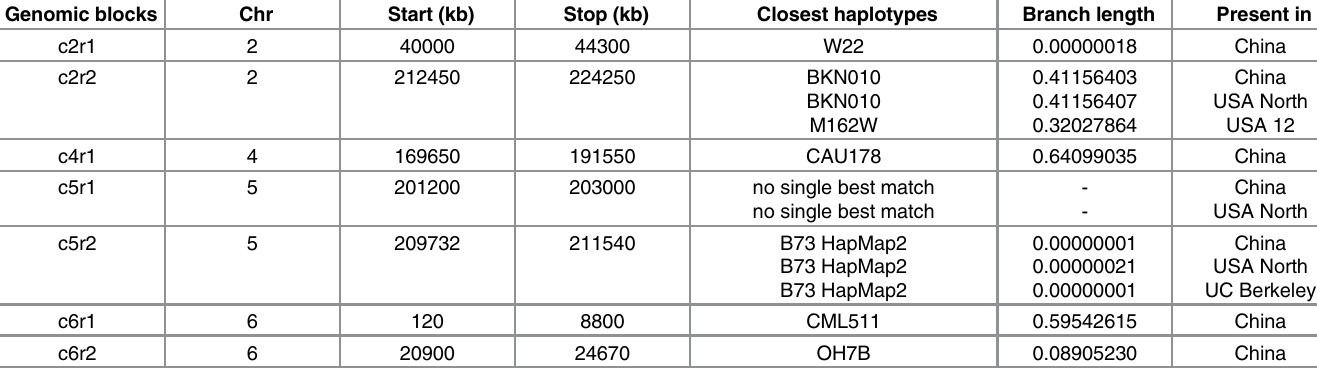
Table 2. Relationship of Non-Reference-Genome Like SNP Blocks to Haplotypes Surveyed by HapMap2. Genomic